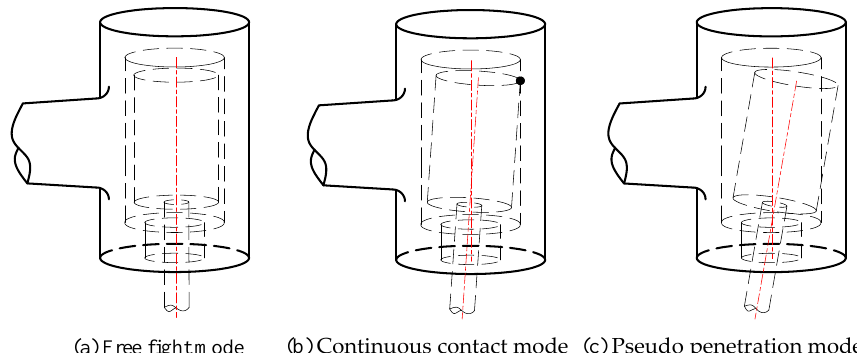
Figure 3. Contact Figure 3. Contact modes.